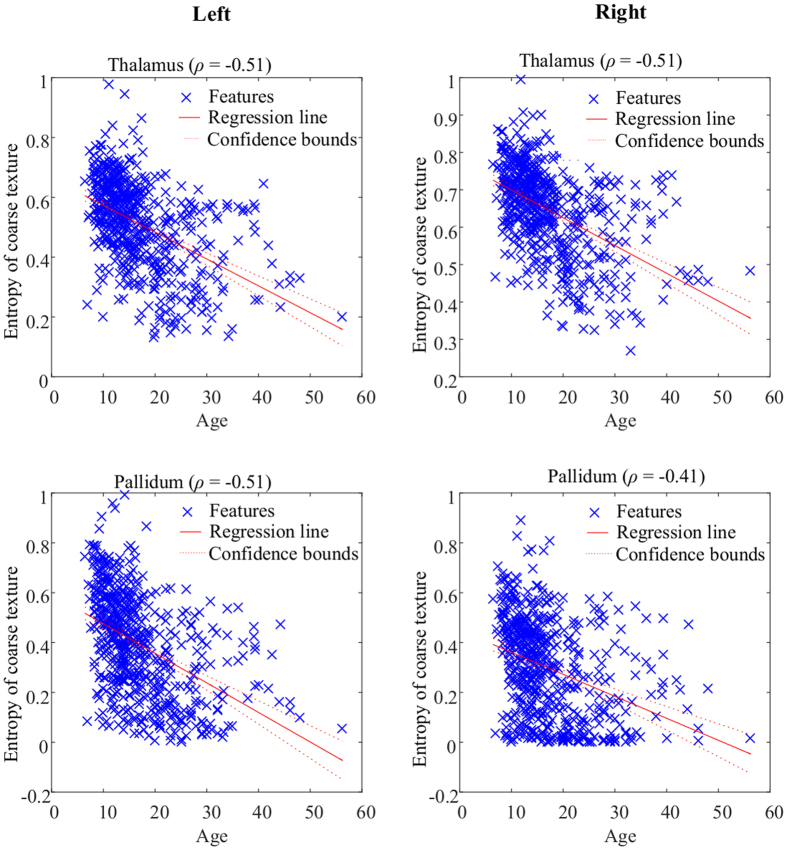
Scatter plots of the Entropy (coarse texture) feature derived from thalamus and pallidum versus age, with Spearman rank correlation coefficients (ρ) shown above each panel.Note the degree of bilateral symmetry.